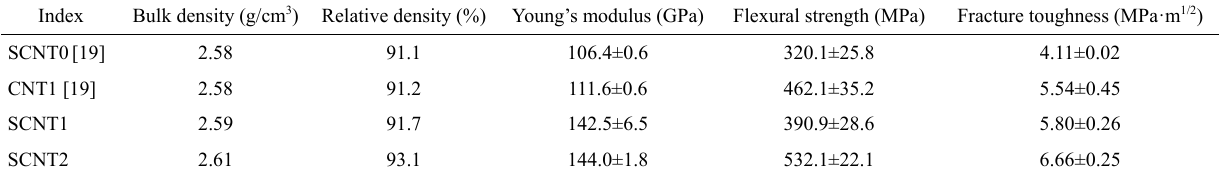
Fig. 8 TEM micrographs of specimen SCNT2. (b, c, d) represent the squares A, B, and C marked in Fig. 8(a), respectively. Table 1 Physical and mechanical properties of Si 2 BC 3 N